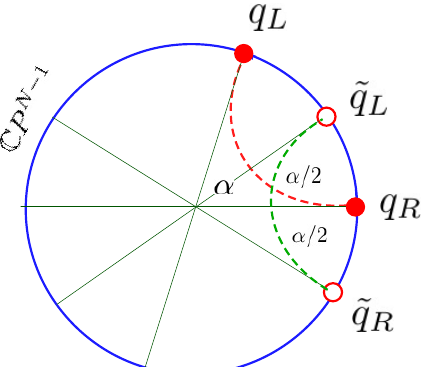
Figure 1. Boundary conditions (2.27) and (2.31). The orientation vectors in the two cases are simply related by a rotation by (cid:11)= 2 of the CP N (cid:0) 1 frame and are clearly equivalent. The dashed lines show schematically the movement of the classical (cid:12)eld from one boundary to the other. The circles stand for the CP N (cid:0) 1 points to which the (cid:12)elds approach at the